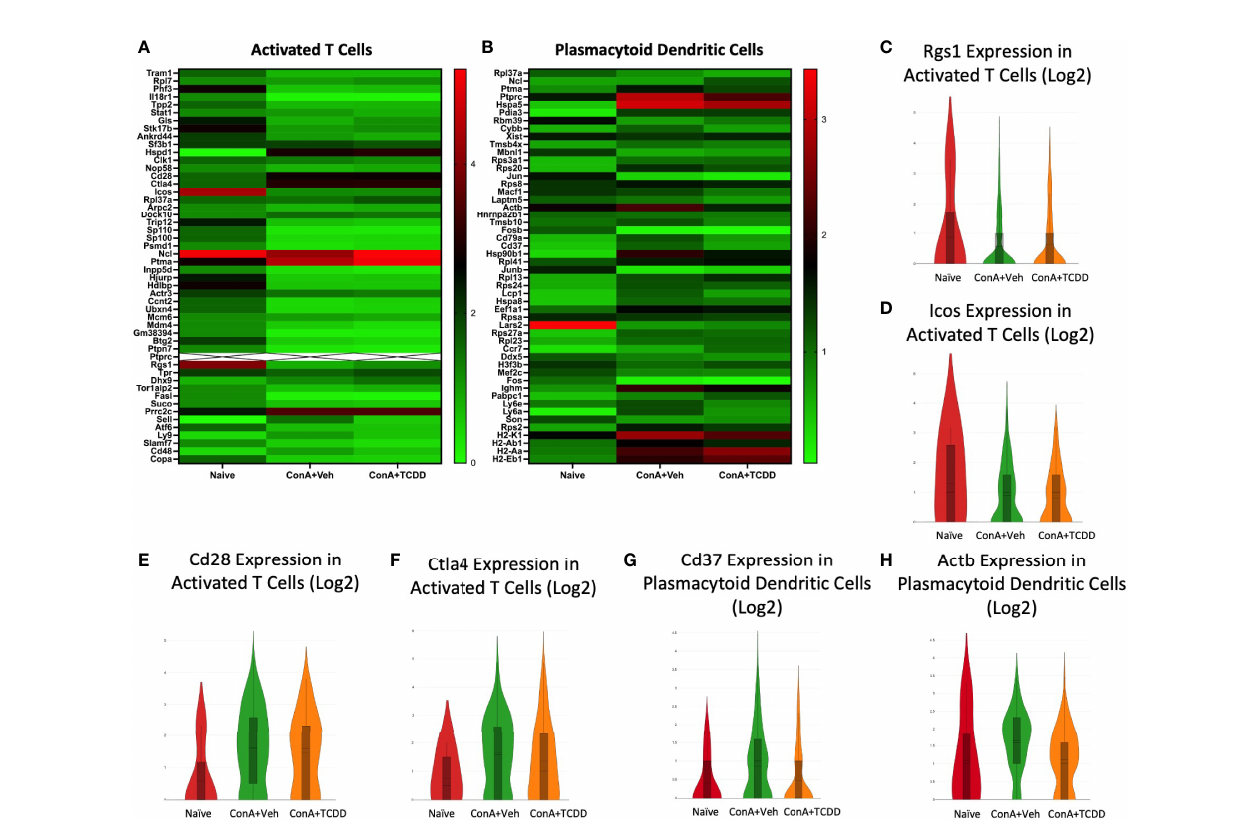
FIGURE 9 | Rgs1, Icos, Cd28, and Ctla4 in Activated T cells and Cd37 and Actb expression in Plasmacytoid Dendritic Cells. C57/BL6 mice were injected with ConA followed by vehicle or TCDD 1 hour later as described in Figure 1 legend. Liver in fi ltrating cells were isolated and scRNA-seq was performed as described in Methods. Heatmaps consisting of the top 50 differentially expressed genes per treatment were generated using Loupe Browser. Heatmaps of differentially expressed genes from (A) Activated T cells and (B) Plasmacytoid Dendritic Cells. In panel (A) , the X marked with some genes represents an expression level over 9. (C – H) Violin plot of Log2 expression of target